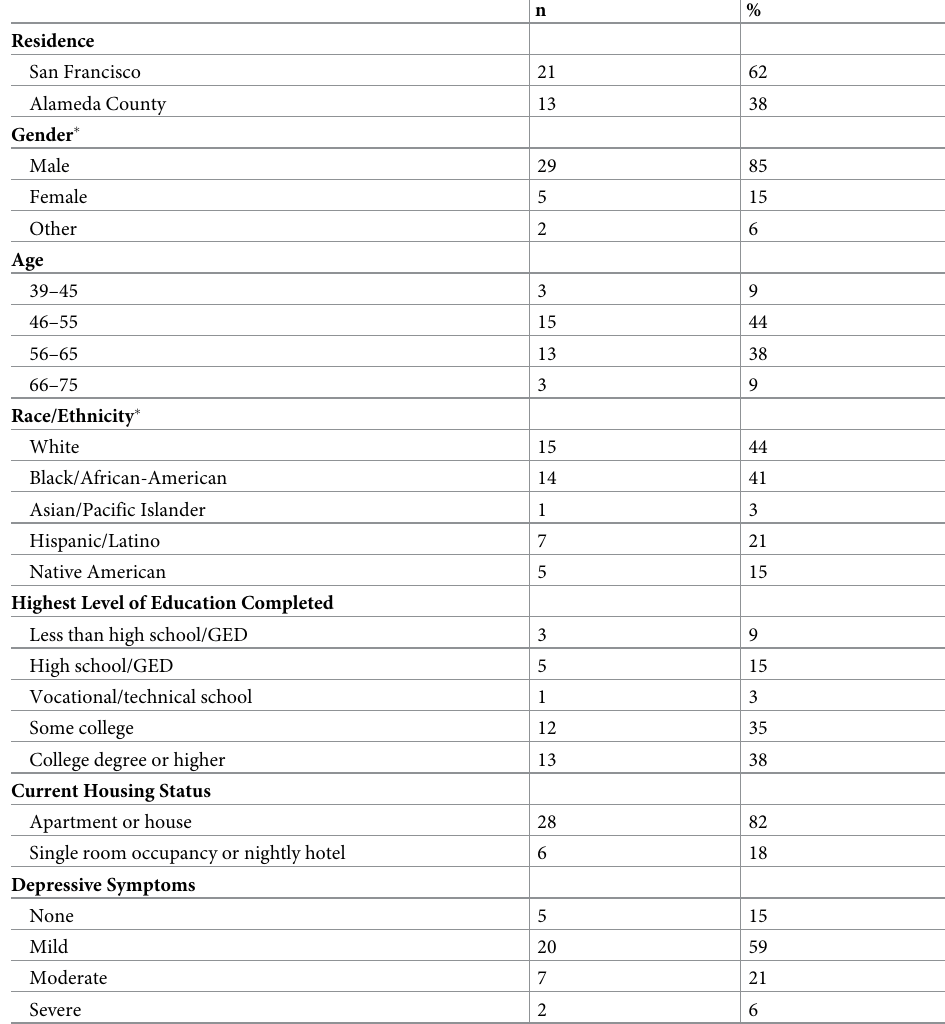
Table 1. Baseline characteristics of study participants (n =